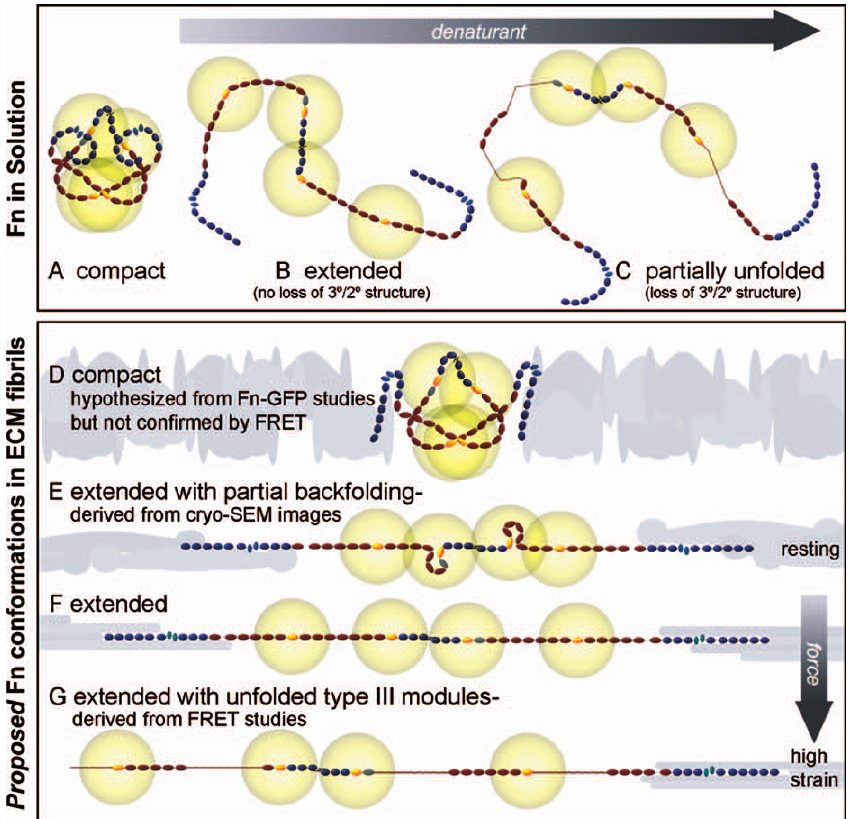
Figure 1. Schematic Sketch of Putative Fn Conformations in Solution and within ECM Fibrils Fn consists of tandem repeats of type I (dark blue ovals), II (narrow, light blue ellipses), and III modules (dark red ovals). Average end-to-end lengths of each module type are drawn to scale using lengths of 2.5 nm for Fn type I [51], 0.7 nm for Fn type II [52], and 3.2 nm for FnIII modules [53]. Two free cysteines are present on each monomer within FnIII 7 and III 15 (yellow). Energy transfer between donors and acceptors bound to free cysteines are limited to within approximately double the Fo¨rster radius ( ; 12 nm), denoted by gold circles around III 7 and III 15 . Fn in solution assumes a compact conformation stabilized through ionic interactions between dimer arms (A) [7]. Denaturant destabilizes these ionic interactions, leading to an extended conformation (B), and higher denaturant concentrations lead to loss of tertiary/secondary structure of FnIII modules (C). The quaternary model for fibril elongation [11,12] predicts a compact conformation with crossover of opposing arms in the absence of tension (D). In contrast, high-resolution cryo- scanning electron microscopic images of Fn fibrils [39,40], taken together with our FRET studies, suggest that fully relaxed fibers do not contain the compact quaternary structure, but are composed of Fn in an extended conformation with partial backfolding of its arms upon themselves (nodules; E). Cell-generated tensile forces first extend Fn fibrils (F) and finally unfold FnIII modules